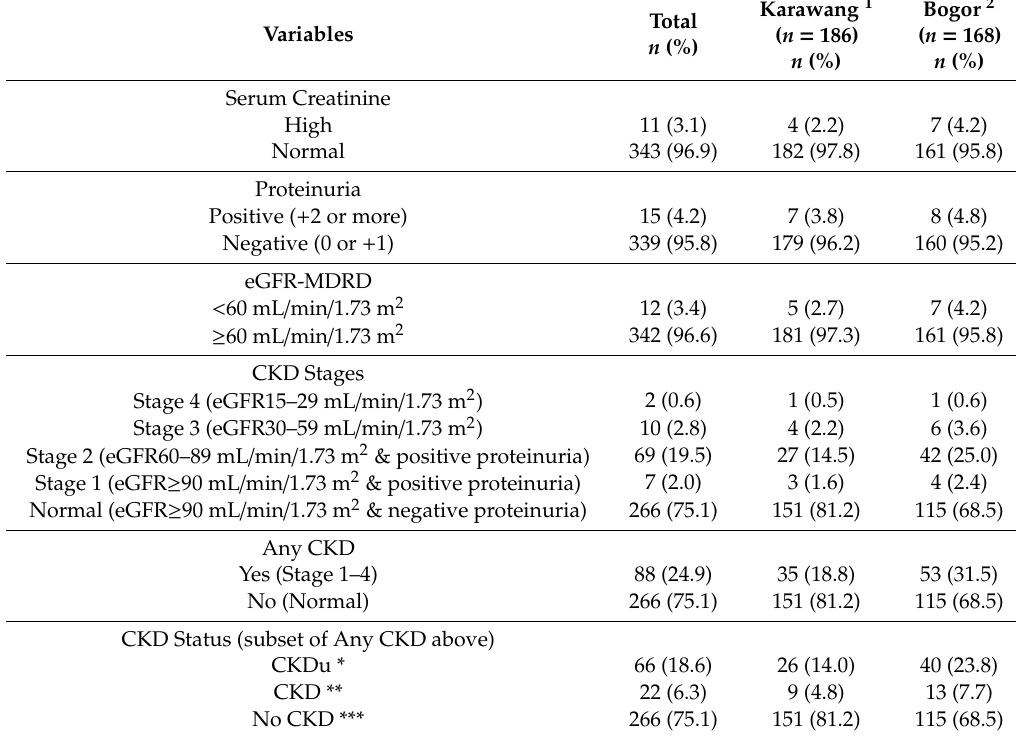
Table 2. Chronic kidney disease (CKD) parameters of male farmers in Karawang and Bogor, West